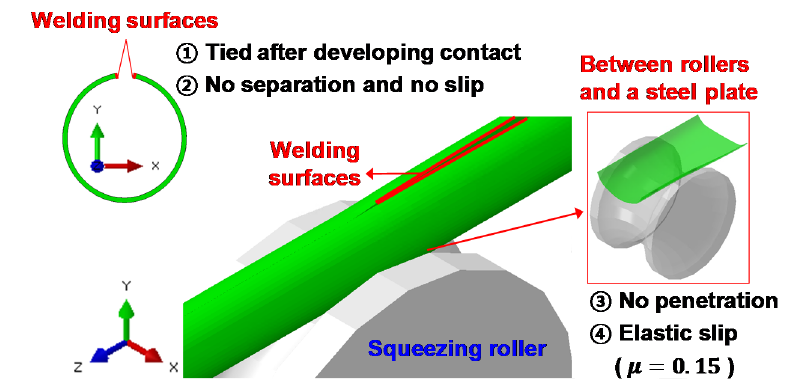
Figure 4. Contact conditions between the plate and rollers.